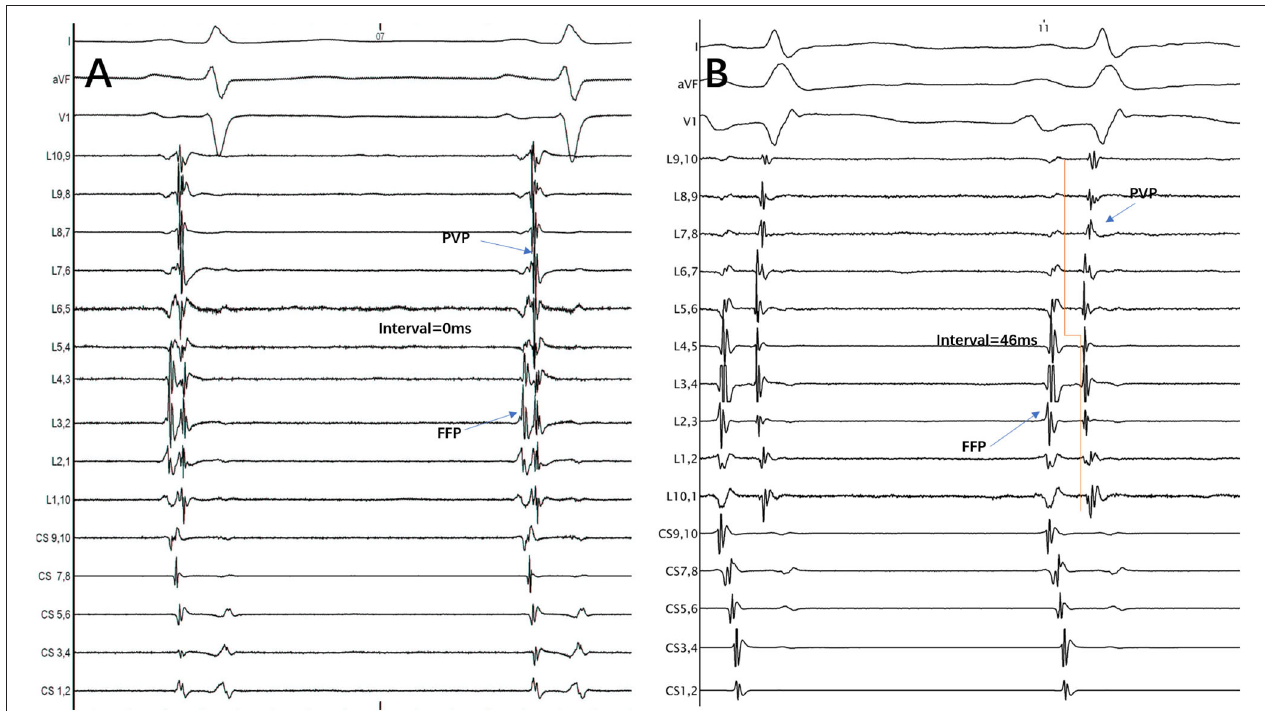
FIGURE 1 | The interval between FFP and PVP at the Lasso catheter was measured from the FFP offset to the earliest PVP onset. (A) FFP and PVP overlapped, so the interval between them was defined as the value of 0ms. (B) FFP and PVP were separated, so the interval between them was 46ms. FFP, far-field atrial potential; PVP, pulmonary vein potential; CS, coronary sinus; L1.2, Lasso catheter distal electrode; L9.10, Lasso catheter proximal electrode.